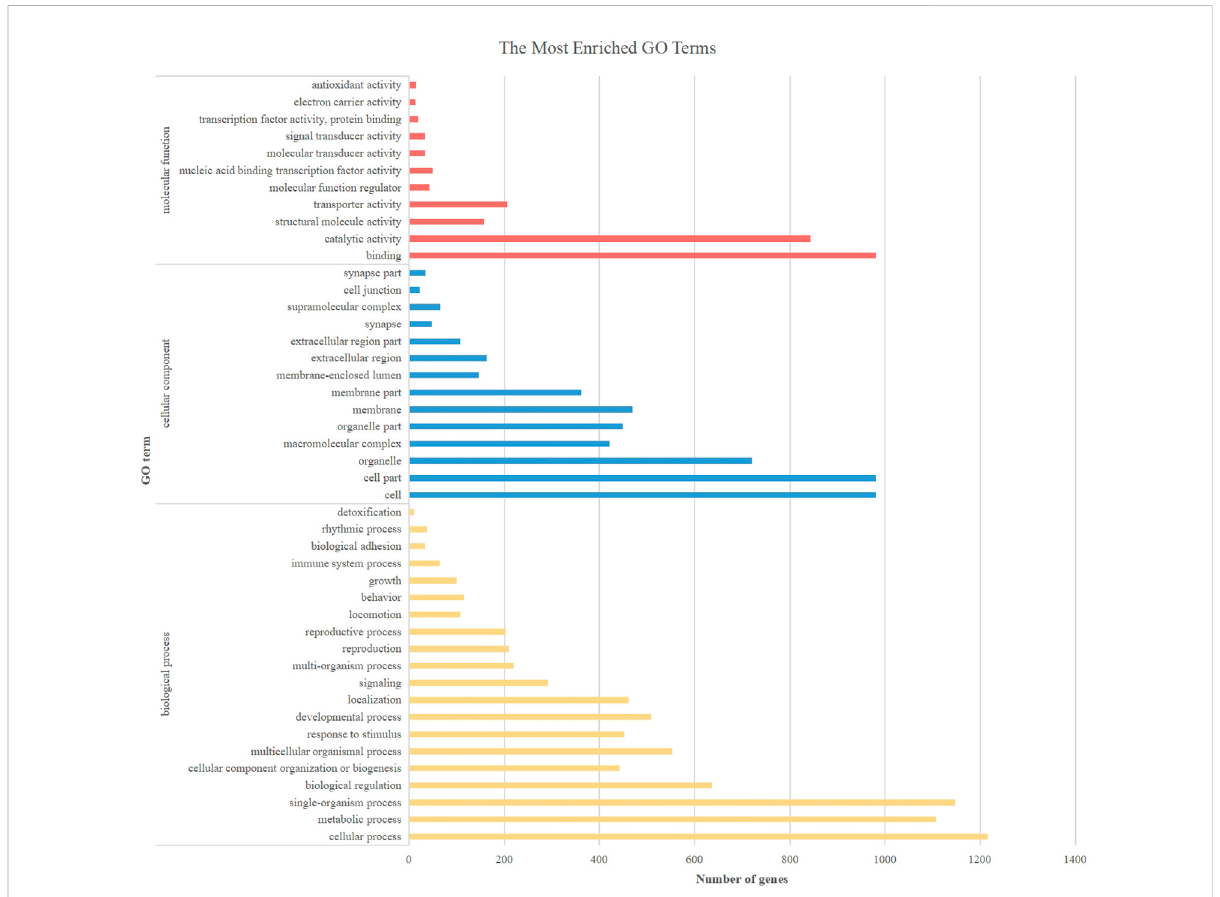
FIGURE 4 GO functional classi fi cation of common differential genes after fi pronil